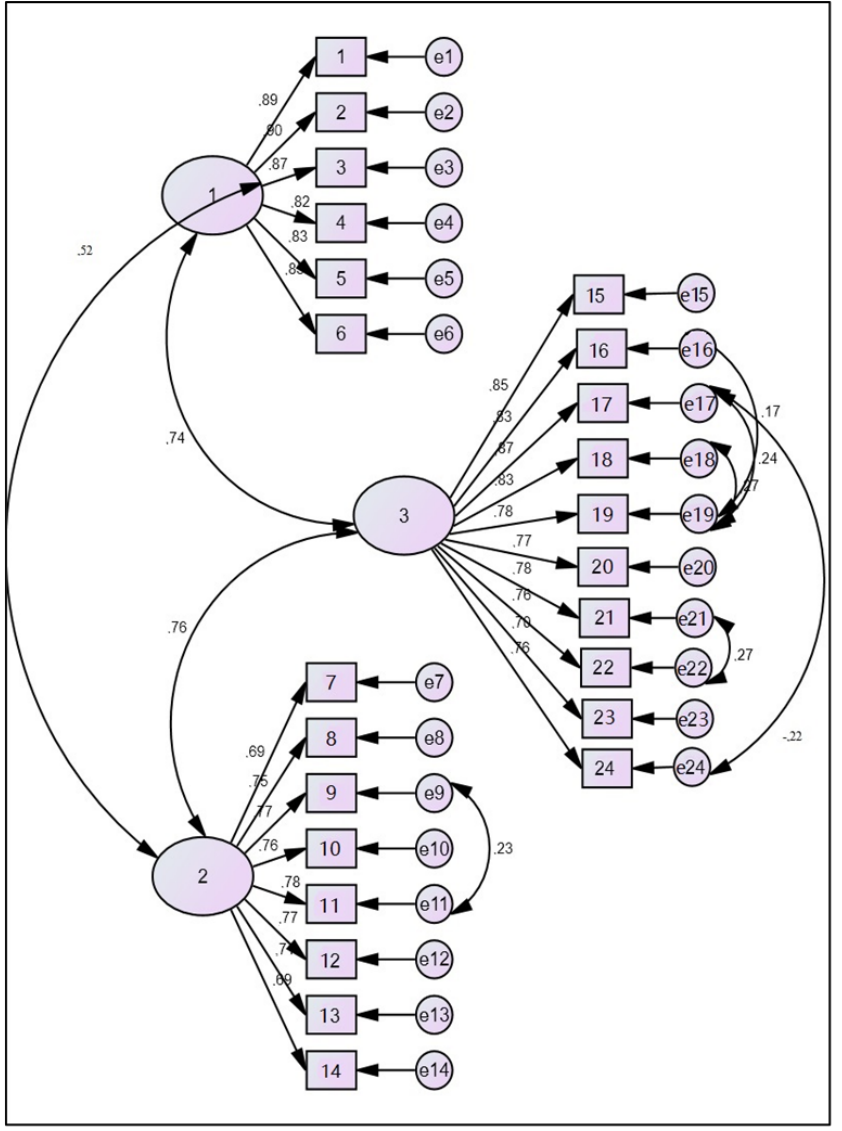
Figure 2. The three-correlated-factors model with 24 items (1 = F3; 2 = F2; and 3 = F1). Table 4. Indicators of suitability of the tested model.